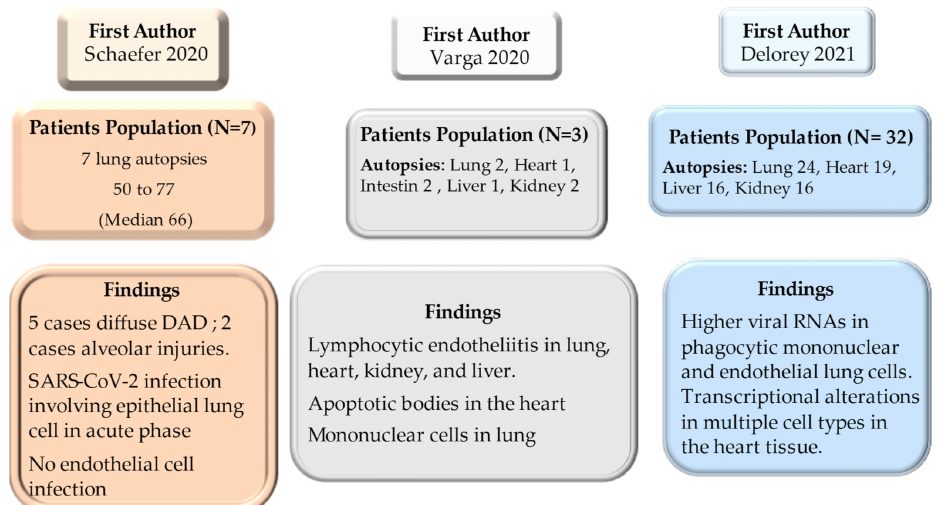
Figure 1. Autopsies substantially contributed to unveiling many unsolved aspects relating to the pathogenesis revealing the role of mononuclear cell infiltration leading to increased cytokine expres- sion in patients who died with single or multi-failure organ pathologies. Abbreviations; DAD, diffuse alveolar damage; IL: interleukine; SARS-CoV-2, severe acute respiratory syndrome coronavirus 2; RNA, ribonucleic acid; TNF, tumor necrosis factor.